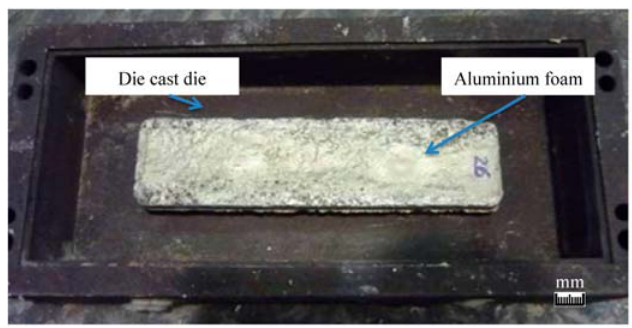
Figure 4. Metallic die to die cast magnesium over the aluminium foam.